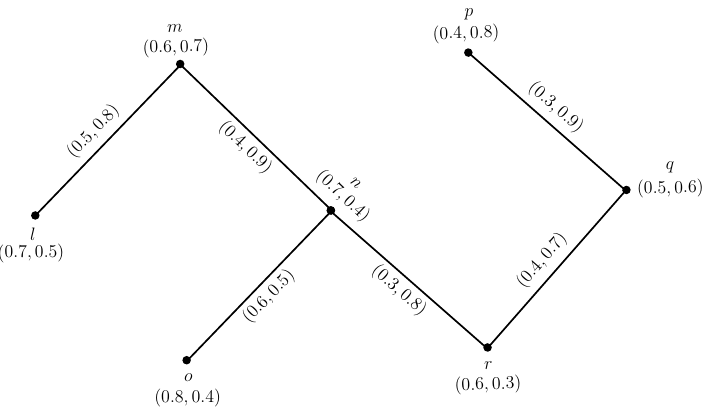
Figure 2. Pythagorean fuzzy graph